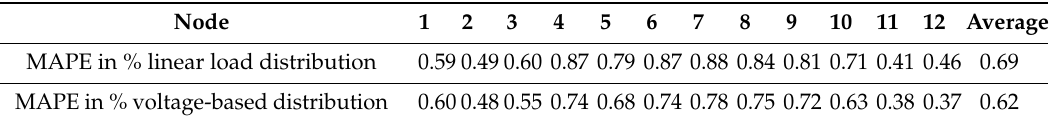
Figure 6. Improvement of the forecasts by using the voltage-based load distribution (one time step) Table 1. Voltage forecast errors at the highlighted